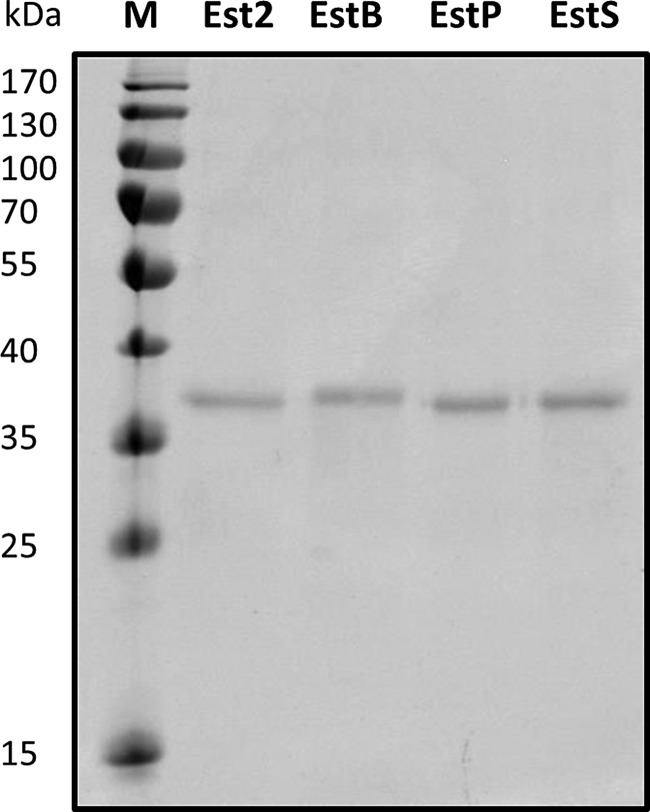
SDS–PAGE analysis of purified recombinant esterases Est2, EstB, EstP and EstS. Enzymes carrying a His6-tag at their C-terminal end were purified by the IMAC method, separated by SDS–PAGE on a 12% (w/v) polyacrylamide gel and stained with Coomassie Brilliant Blue G-250. Molecular weights of standard proteins are indicated on the left.